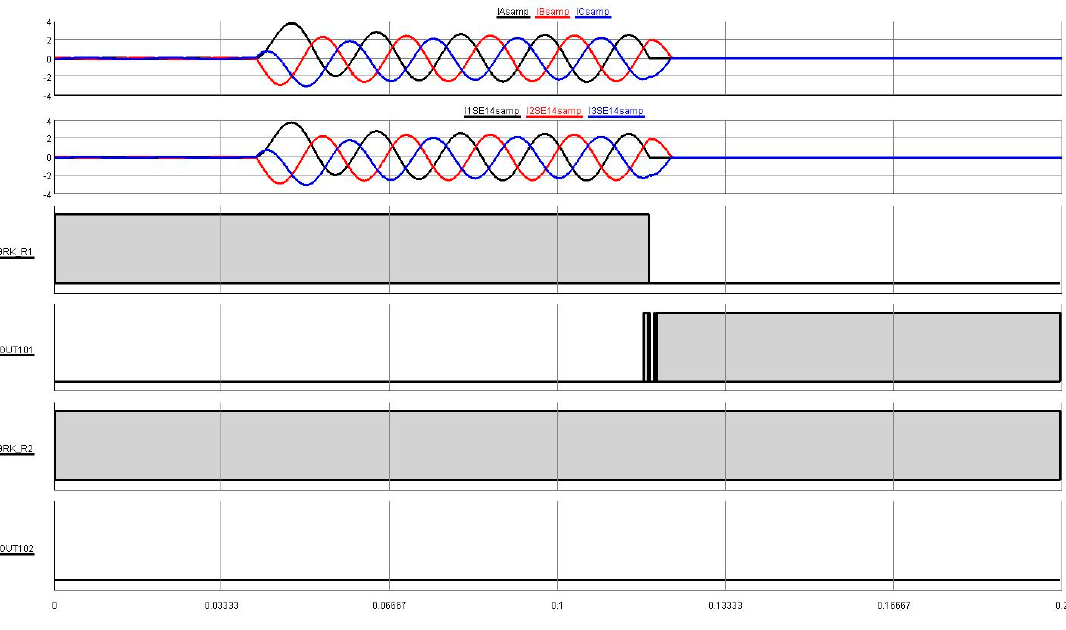
Figure 25. Waveforms for fault condition when R1 operates—case 2.